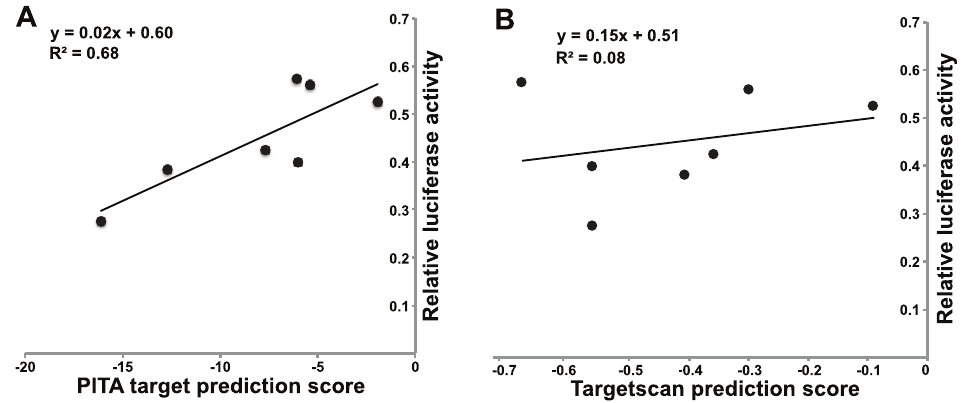
Figure 3. Correlation of PITA and Targetscan prediction scores with repression by miR-30ac2. The PITA (left) and Targetscan (right) scores are plotted on the x-axis, with the relative level of luciferase activity following miR-30ac2 over-expression on the